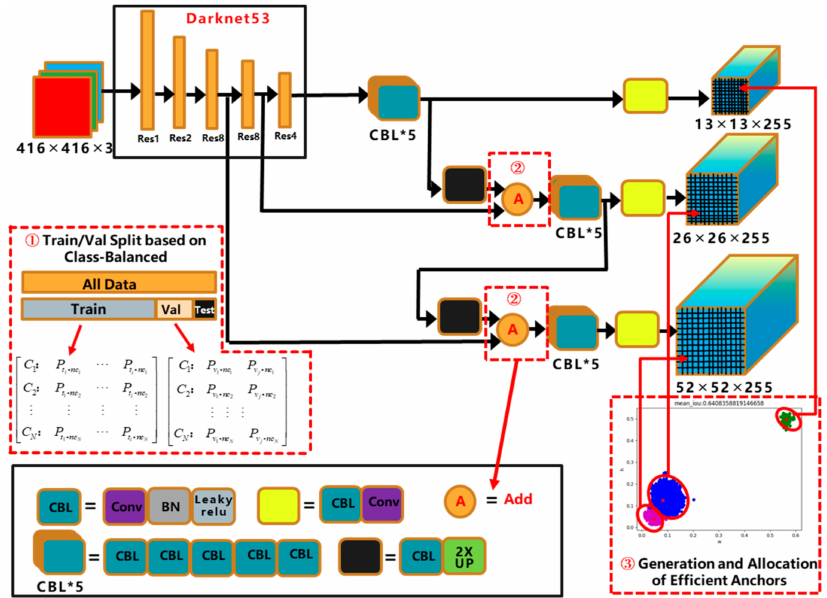
Figure 1. A framework of